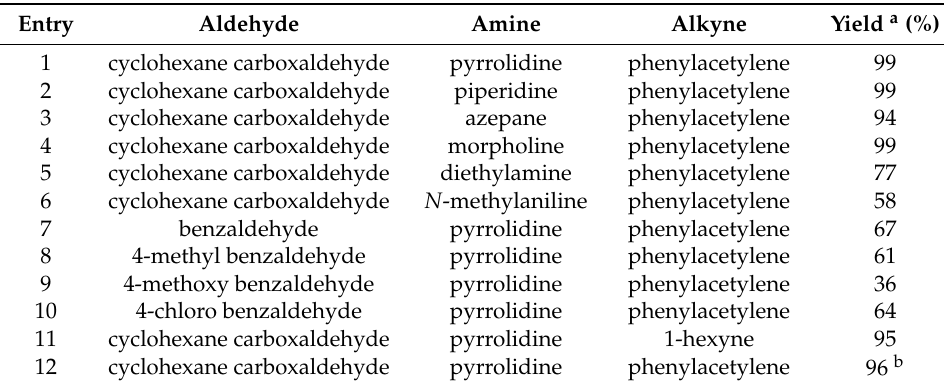
Table 3. Catalytic activity of 1 in the A 3